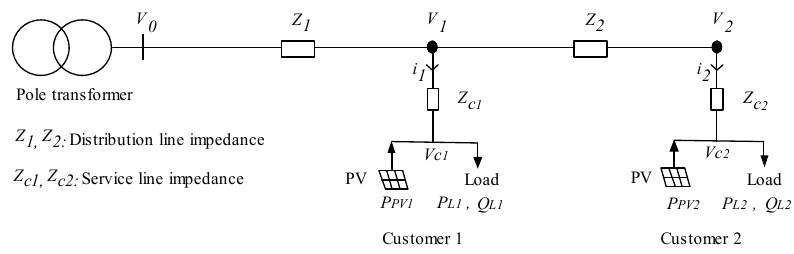
Figure 1. A simplified two-customer power distribution system model.